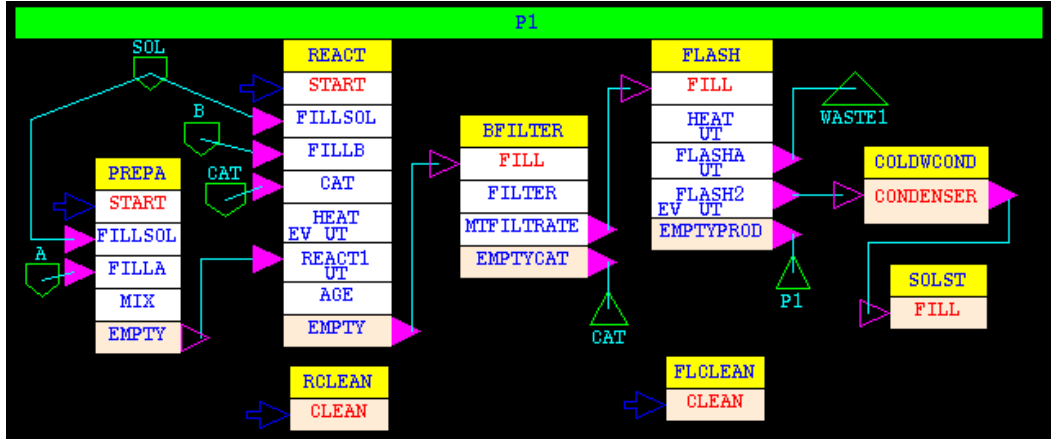
Figure A2. Recipe network for the modified recipe.